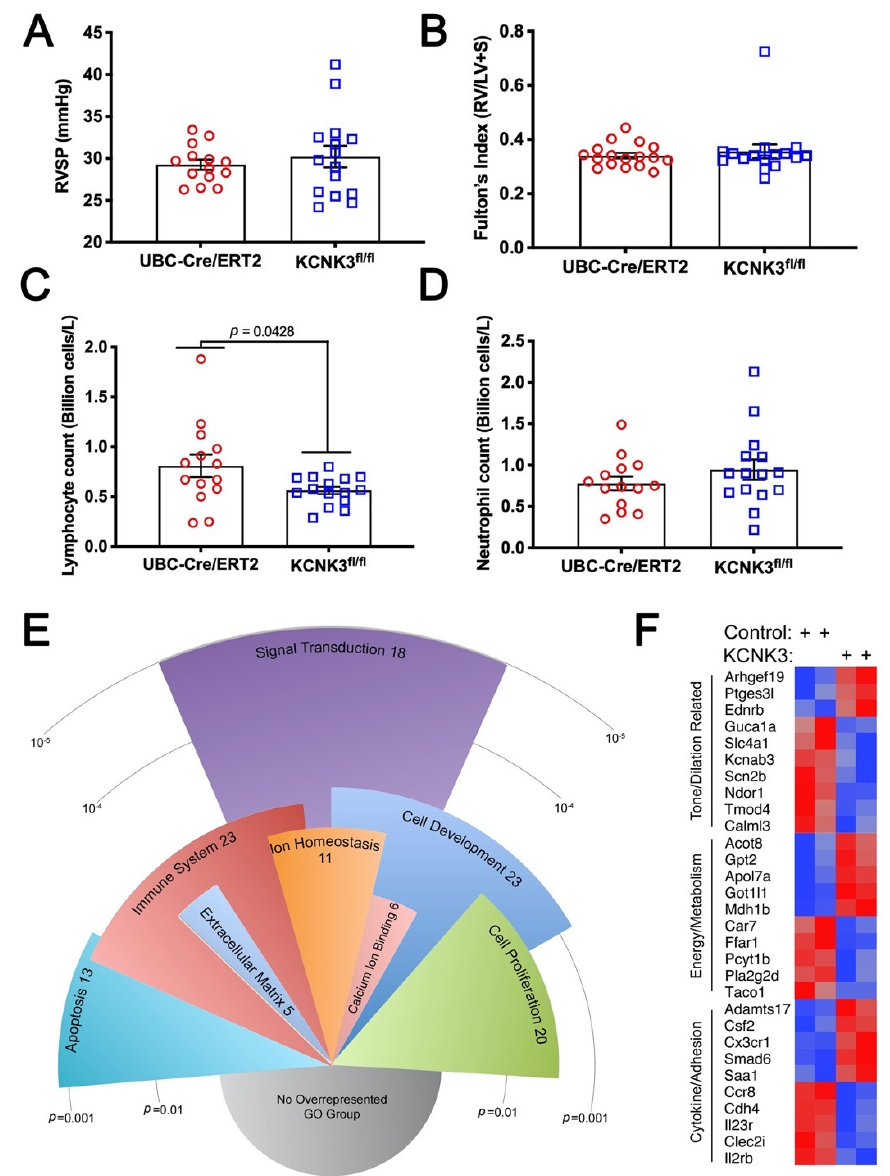
Figure 2. ( A ) Four weeks of normobaric hypoxia (10% O 2 ) did not consistently result in higher right ventricular systolic pressures in kcnk3 fl/fl mice. All mice carried the UBC-Cre/ERT gene and were Tamoxifen treated. ( B ) Normobaric hypoxia did not result in right ventricular hypertrophy in kcnk3 fl/fl mice. ( C ) Kcnk3 fl/fl mice had lower lymphocyte count than controls. ( D ) Other elements of the white blood count were normal (neutrophil count shown as an example). ( E ) RNA-Seq comparing lungs from kcnk3 fl/fl mice to controls. Overrepresented gene ontology groups from 138 genes with p < 0.05 for change between groups and at least 1.25-fold changed expression (up or down) in the kcnk3 fl/fl mice compared to controls. Radius corresponds to multiple-comparisons adjusted p -value; angular width corresponds to number of genes. ( F ) Heat map of 30 genes whose pathways had been previously implicated in pulmonary arterial hypertension, related to vascular tone, metabolism, and inflammatory cell recruitment or adhesion. Red indicates higher expression, blue lower expression.